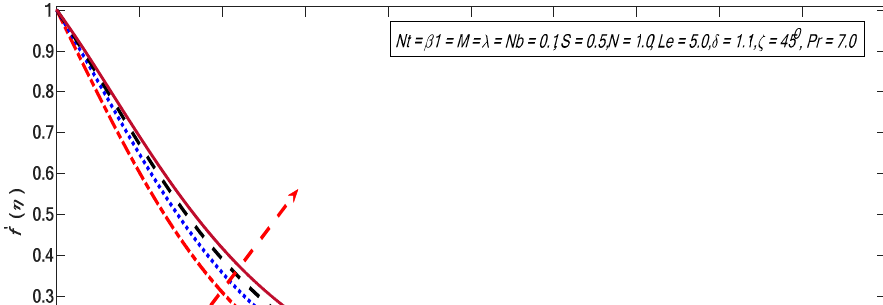
Figure 3. Variations in angular velocity for several values of 𝑀 .